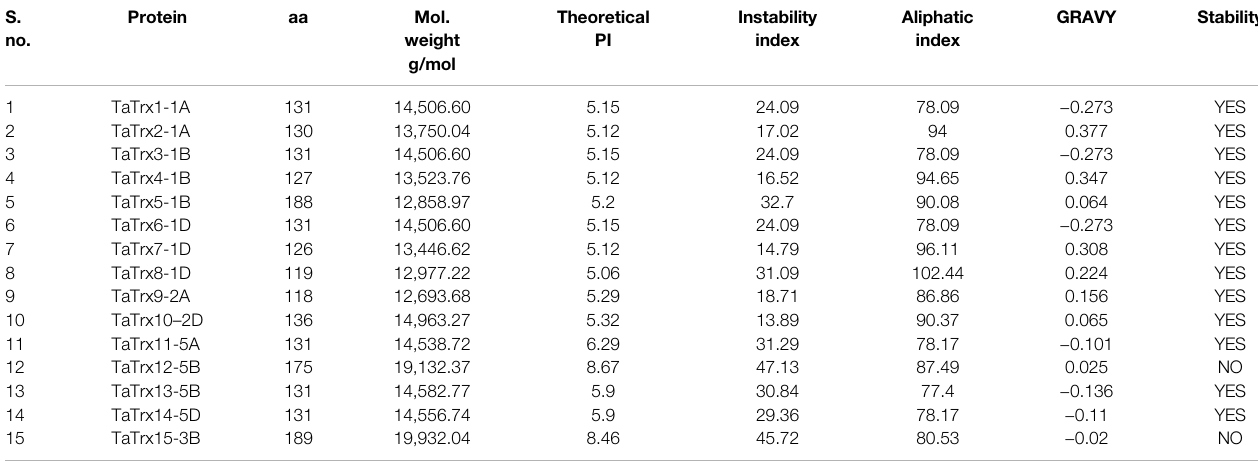
TABLE 2 | Predicted physicochemical properties of TaTrx